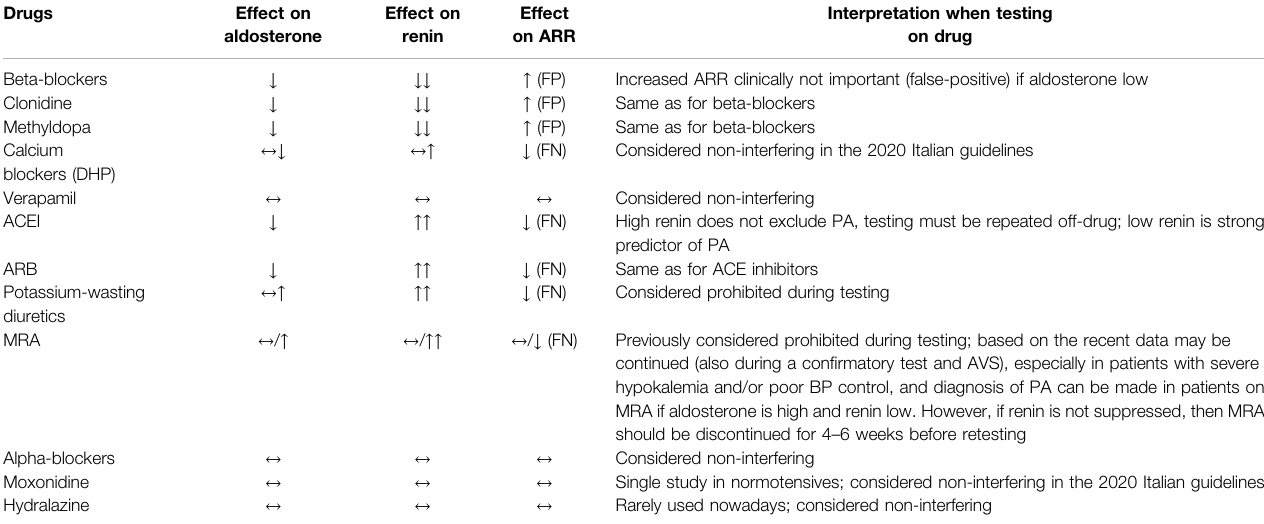
TABLE 2 | Effect on antihypertensive drugs on aldosterone, renin, and aldosterone-to-renin